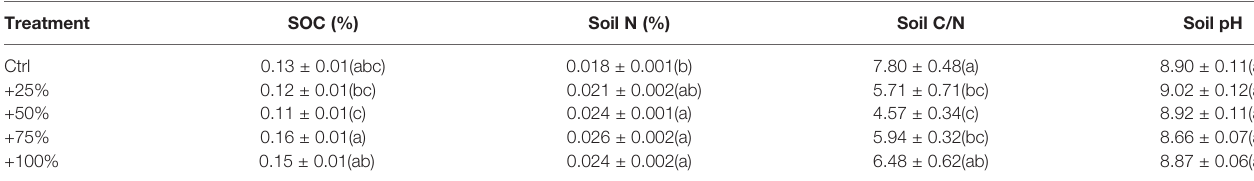
TABLE 1 | Mean ( ± SE) values of soil chemical properties in 0 – 10 cm deep soil at the end of the 2010 growing season (n = 4).